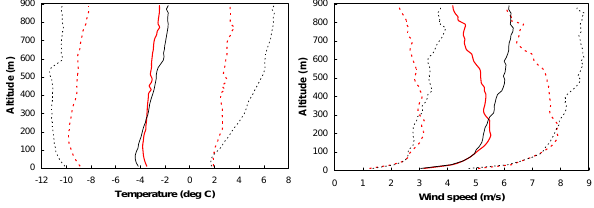
Fig. 4. The average profiles of (a) air temperature, and (b) wind speed based on all 43 profiles with LLJs observed (red) and on the 52 profiles without a LLJ (black). The dotted lines indicate the mean ± standard